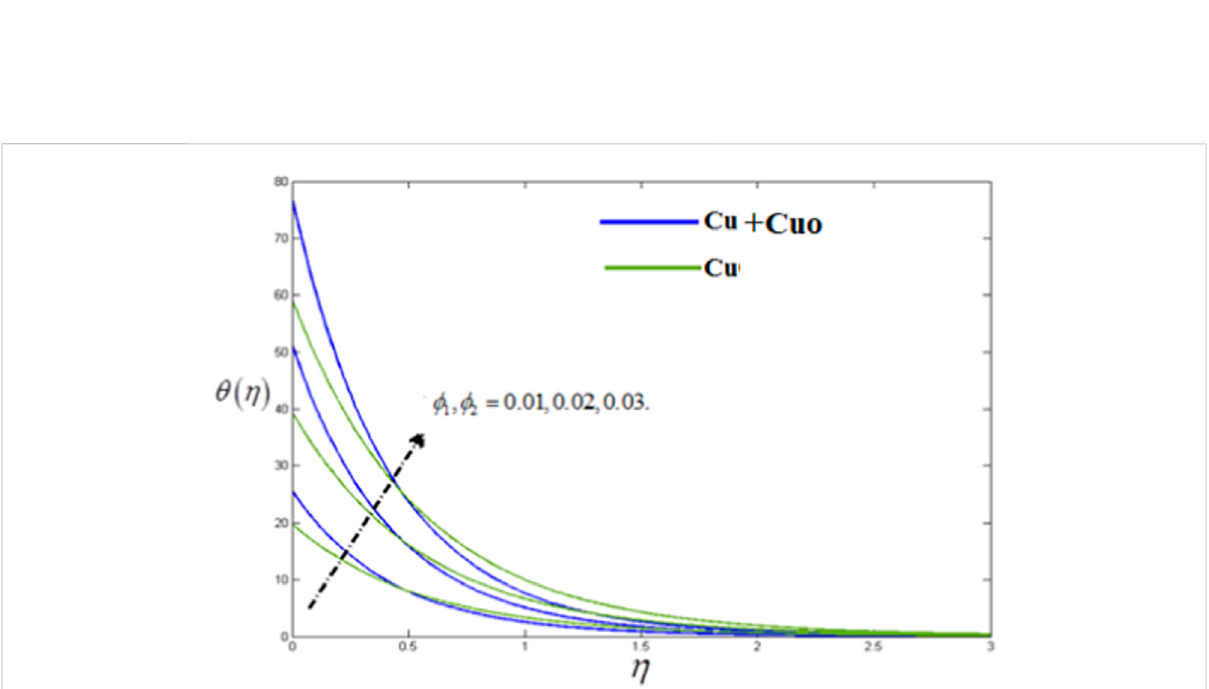
FIGURE 9 ϕ ϕ θ ( η ) . When, k (cid:2) 0 . 2 , Λ (cid:2) 0 . 4 , B 1 , 2 versus